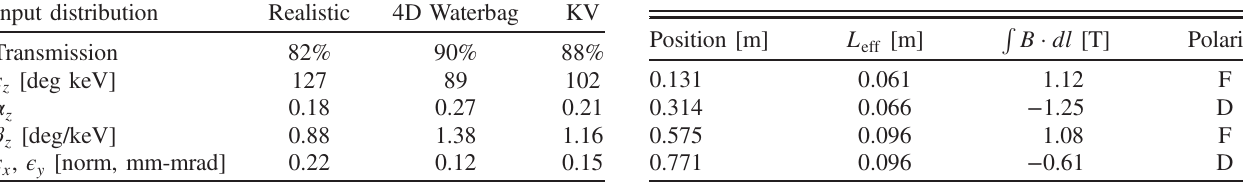
TABLE III. Parameters used for four-quadrupole MEBT trans- port line between RFQ at s ¼ 0 and plane of first vertical slit at s ¼ 1 . 326